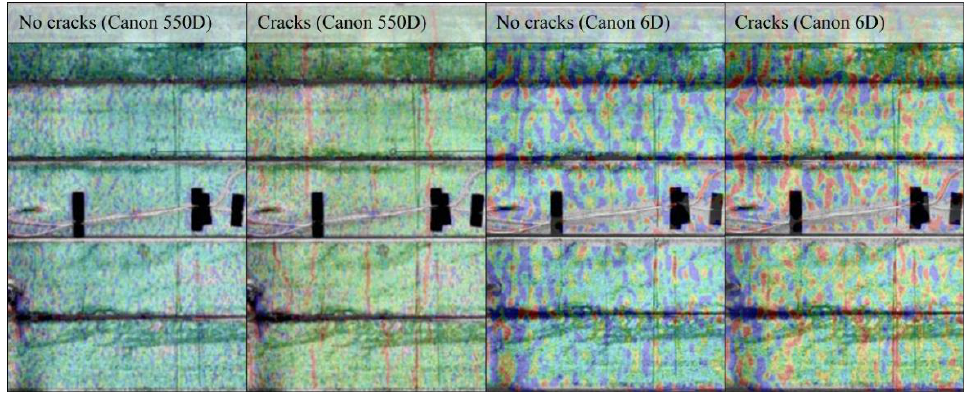
Figure 17. Time of crack detection for different subset sizes (15/5, 30/10, 45/15), Strip 2 (Canon 550D).